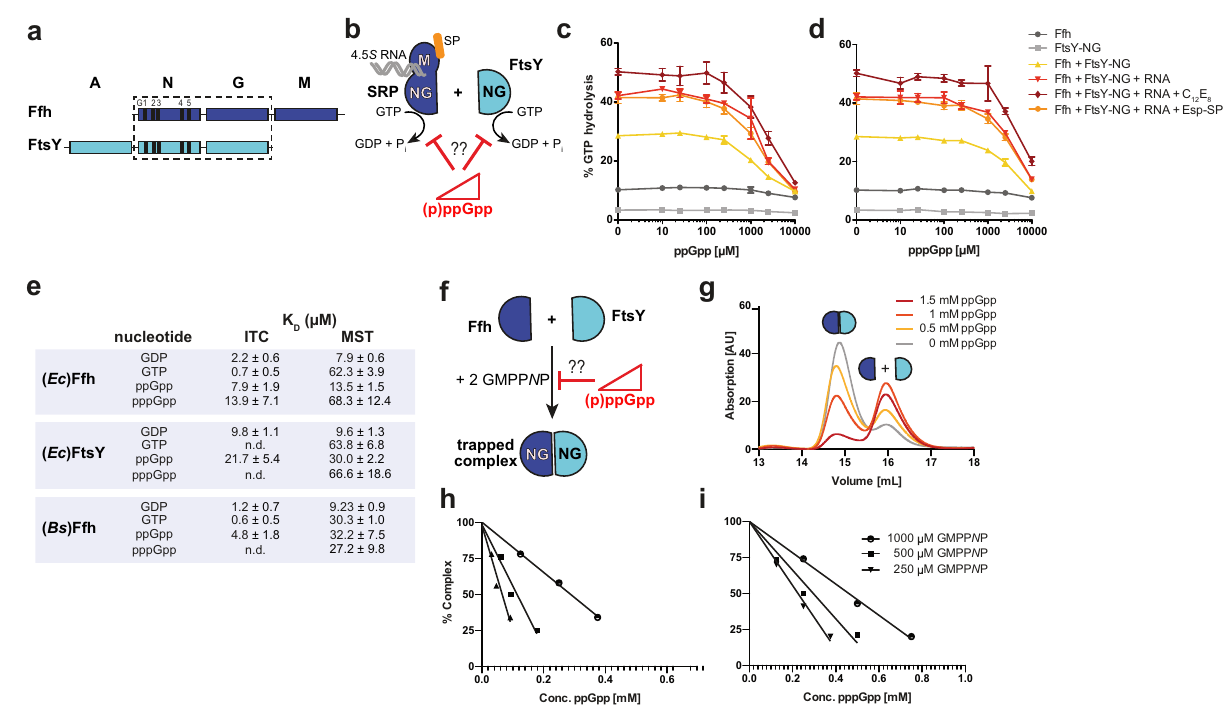
Fig. 3 (p)ppGpp reduces GTPase activity and complex formation of SRP and FtsY. a Domain architecture of the bacterial SRP-GTPases Ffh (blue) and FtsY (cyan), both sharing the conserved GTPase-containing NG domain. The G-elements G1 – G5 as well as the A and M domains speci fi c to FtsY and Ffh, respectively, are shown. b Scheme of the experimental setup for analyzing the impact of increasing concentrations of (p)ppGpp on the GTPase activities of SRP and FtsY. Orange sphere depicts the signal peptide (SP), and gray strands the SRP RNA. c and d GTPase activity of full-length Ffh and FtsY-NG was assayed in the presence of increasing amounts of the competitors ppGpp ( c ) and pppGpp ( d ). Where indicated, 5 µ M ( Ec )FtsY-NG, 6 µ M of 4.5S RNA, 5 µ M Esp-signal peptide and 100 µ M C 12 E 8 (signal peptide mimic) were added to the reaction including 5 µ M full-length ( Ec )Ffh and 1 mM GTP. The data represent mean values (±SD) of n = 3 replicates. e The table lists the K D values obtained for the binding of GDP, GTP, ppGpp and pppGpp to ( Ec )Ffh, ( Ec ) FtsY- and ( Bs )Ffh-NG domains determined either by isothermal titration calorimetry (ITC) or microscale thermophoresis (MST). f Scheme of the experimental setup for analyzing the impact of increasing concentrations of (p)ppGpp on the GTP-dependent formation of the Ffh/FtsY-NG domain complex. g Analytical size-exclusion chromatography (SEC) monitoring the complex formation and dissociation of Ffh-NG and FtsY-NG (100 µ M each) incubated with 1 mM GMPP N P and in the absence or presence of increasing ppGpp concentrations (0, 0.5, 1, and 1.5 mM). h and i Percentage of formed Ffh-NG/FtsY-NG complexes (50 µ M each) in the presence of different GMPP N P concentrations (250, 500, and 1,000 µ M) analyzed in the presence of increasing ppGpp ( h ) and pppGpp ( i ) concentrations,